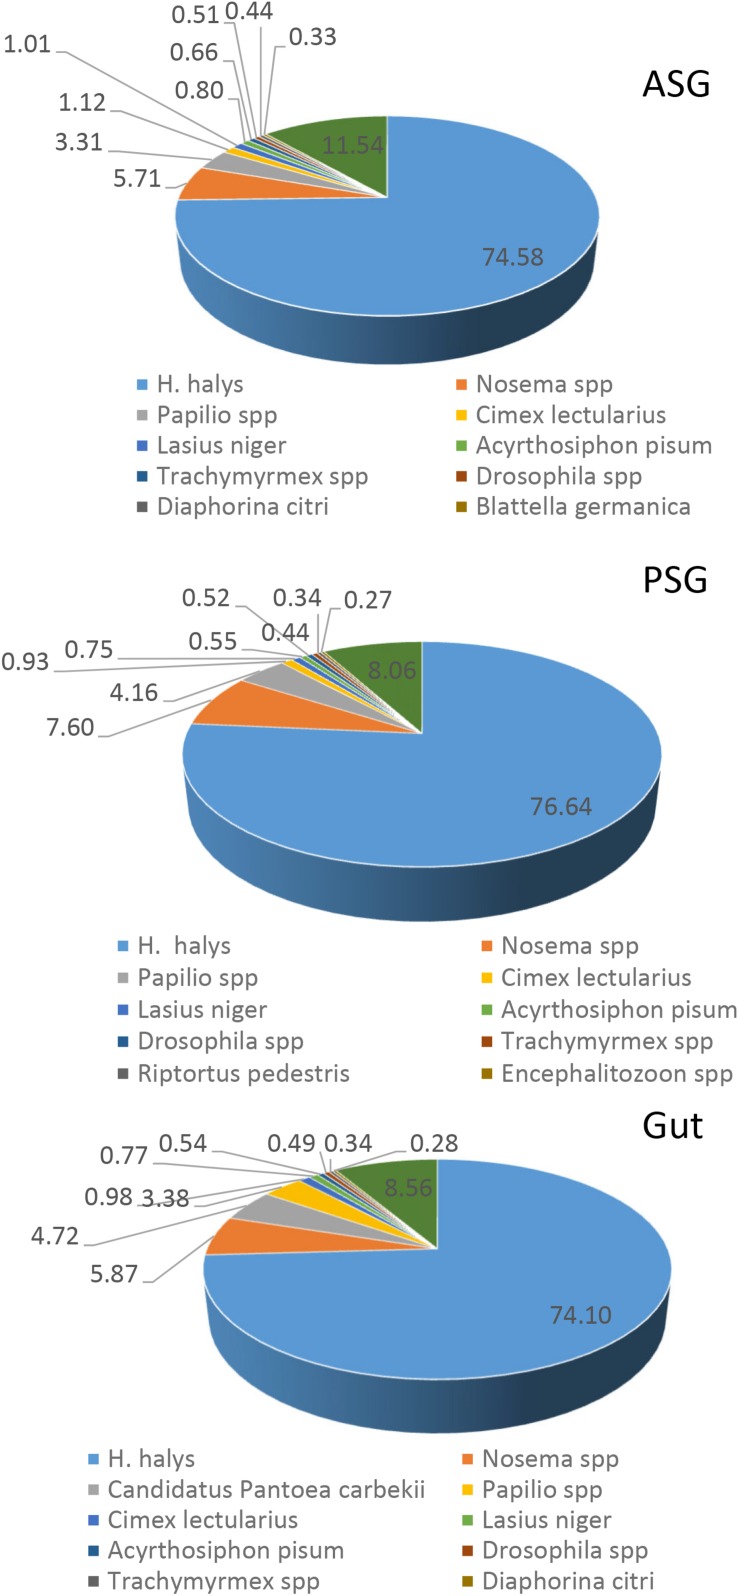
Species distribution of the best BLASTx hits in the nr database for ASG, PSG, and gut transcripts. The proportion (%) of sequences derived from specific species is shown for species with the highest number of hits. Some 75% of the top hit sequences were from predicted genes of H. halys. Transcripts derived from the symbiont Nosema were present in all three tissues, while transcripts of the gut-localized symbiont, Candidatus Pantoea carbekii, were present only in the gut.